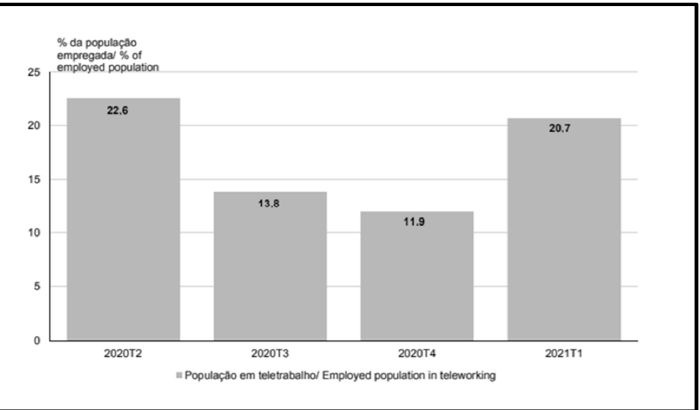
Figure 1. Statistics Portugal, Labour Force Survey (2022). Source: Statistics Portugal, Labour Force Survey (2022).